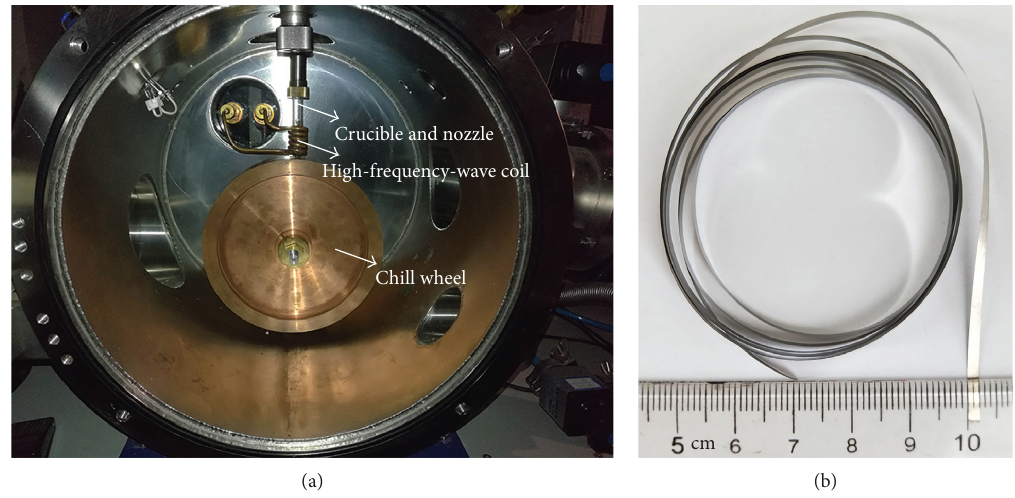
Figure 1: Schematic diagrams of single roller melt-spinning apparatus (a) and ribbon (b).